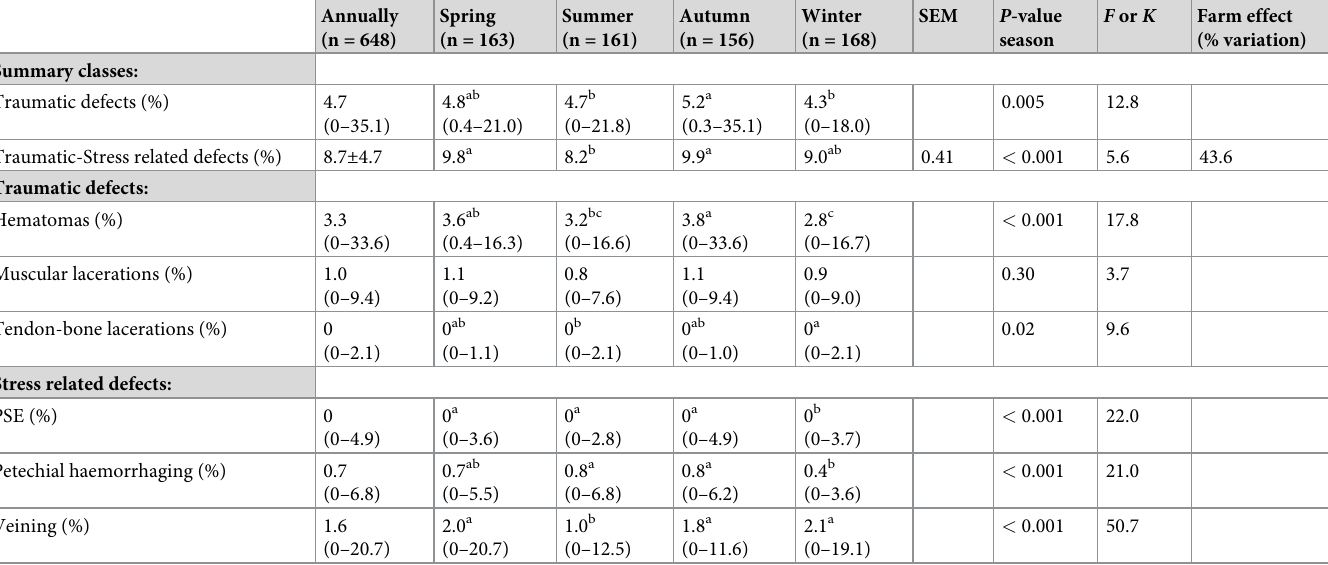
Table 3. Effect of season on the prevalence of different ham defects detected in 648 batches of PDO Italian heavy